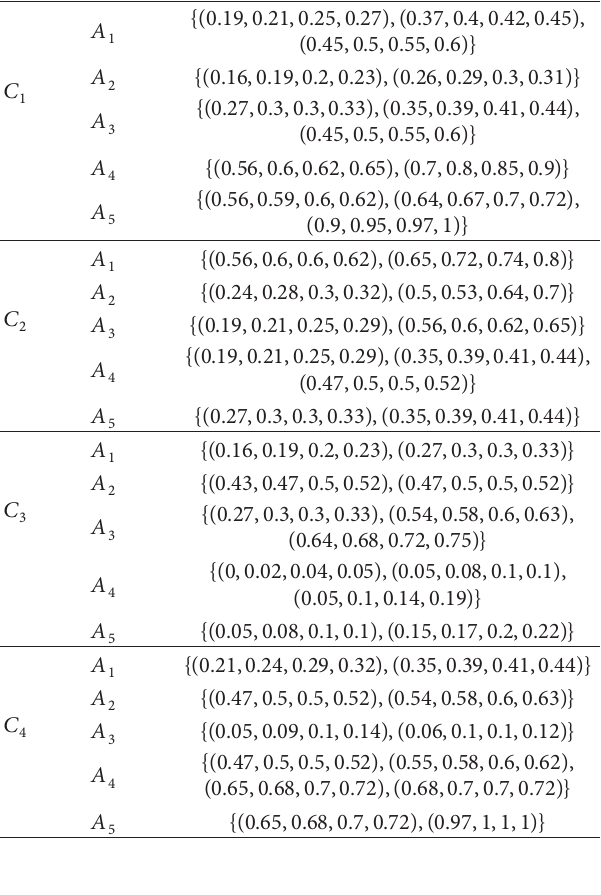
Table 4: Decision matrix (𝑋) .